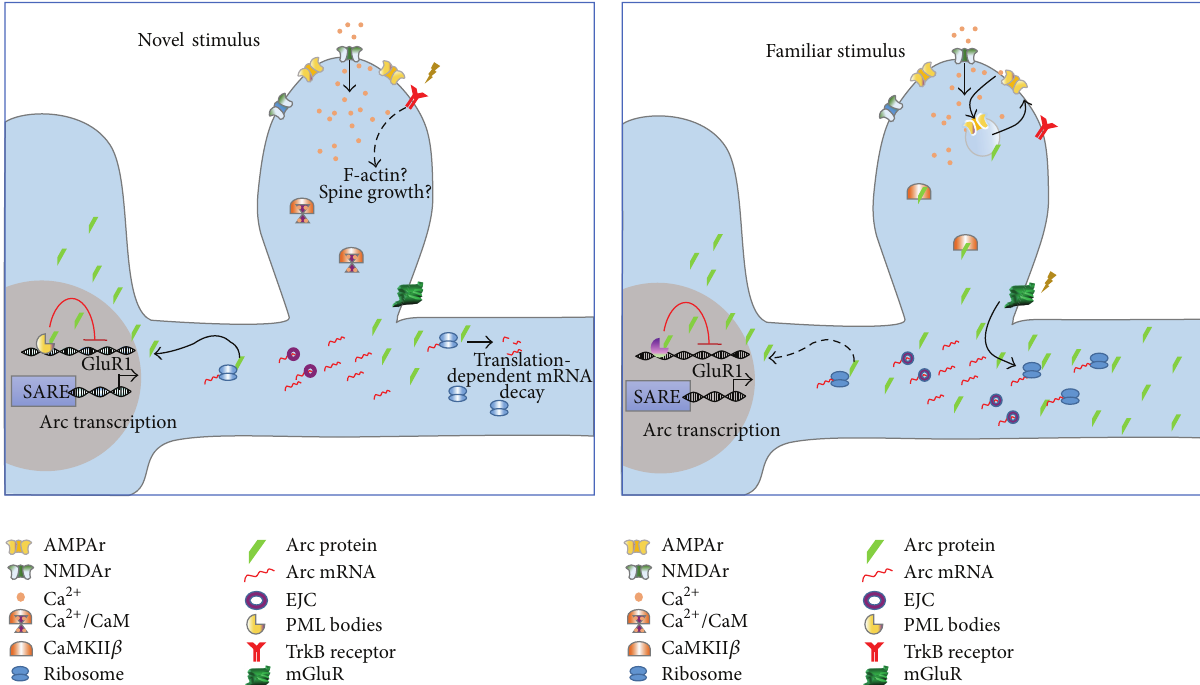
Figure 1: Hypothetical model of the differential role of Arc expression after the presentation of a novel and a familiar stimulus. In both cases, active Arc expressing cells are presented in which a swift and massive calcium entry through NMDA receptors at synaptic sites induce dramatic increase in Arc mRNA expression through “SARE” activation. Further NMDA receptors activation and increased protein synthesis observed after novelty exposure could induce synaptic activity and translation-dependent Arc mRNA degradation as it was observed after DG-LTP [29]. In the novelty condition, increased TrkB activation through BDNF may lead to increase in actin polymerization and spine growth at potentiated synapses, mechanisms that, in addition to LTP, are thought to underlie the consolidation of novel information [30]. On the other hand, familiarization primes dendrites for mGluR1-LTD and increased Arc protein synthesis [31, 32] arguably after reactivation of the same circuit. In addition to synapse-specific downregulation of surface AMPA receptors, a more global, cell-wide mechanism occurs in which Arc is shuttled to the nucleus and associates with PML bodies to repress GluR1 transcription. Accumulation of Arc in the nucleus has been observed in the hours following novel environment exploration [33] and may also occur after familiar stimulus